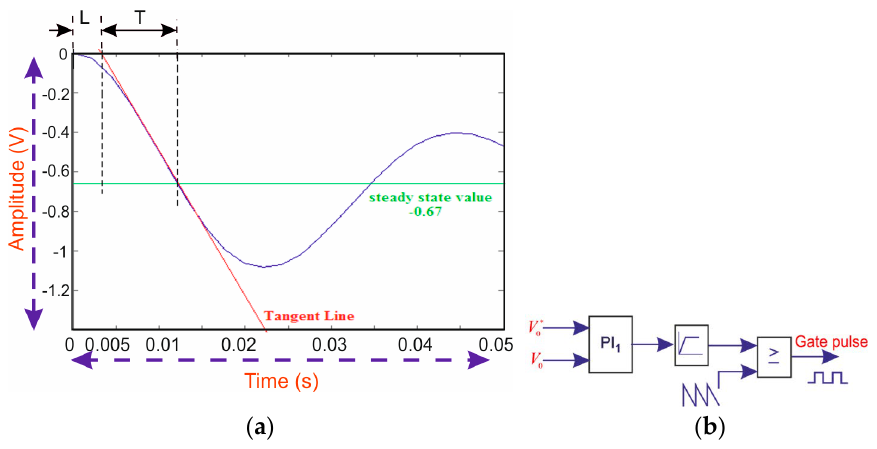
Figure 11. ( a ) S shaped curve. ( b ) Control with PI controller.